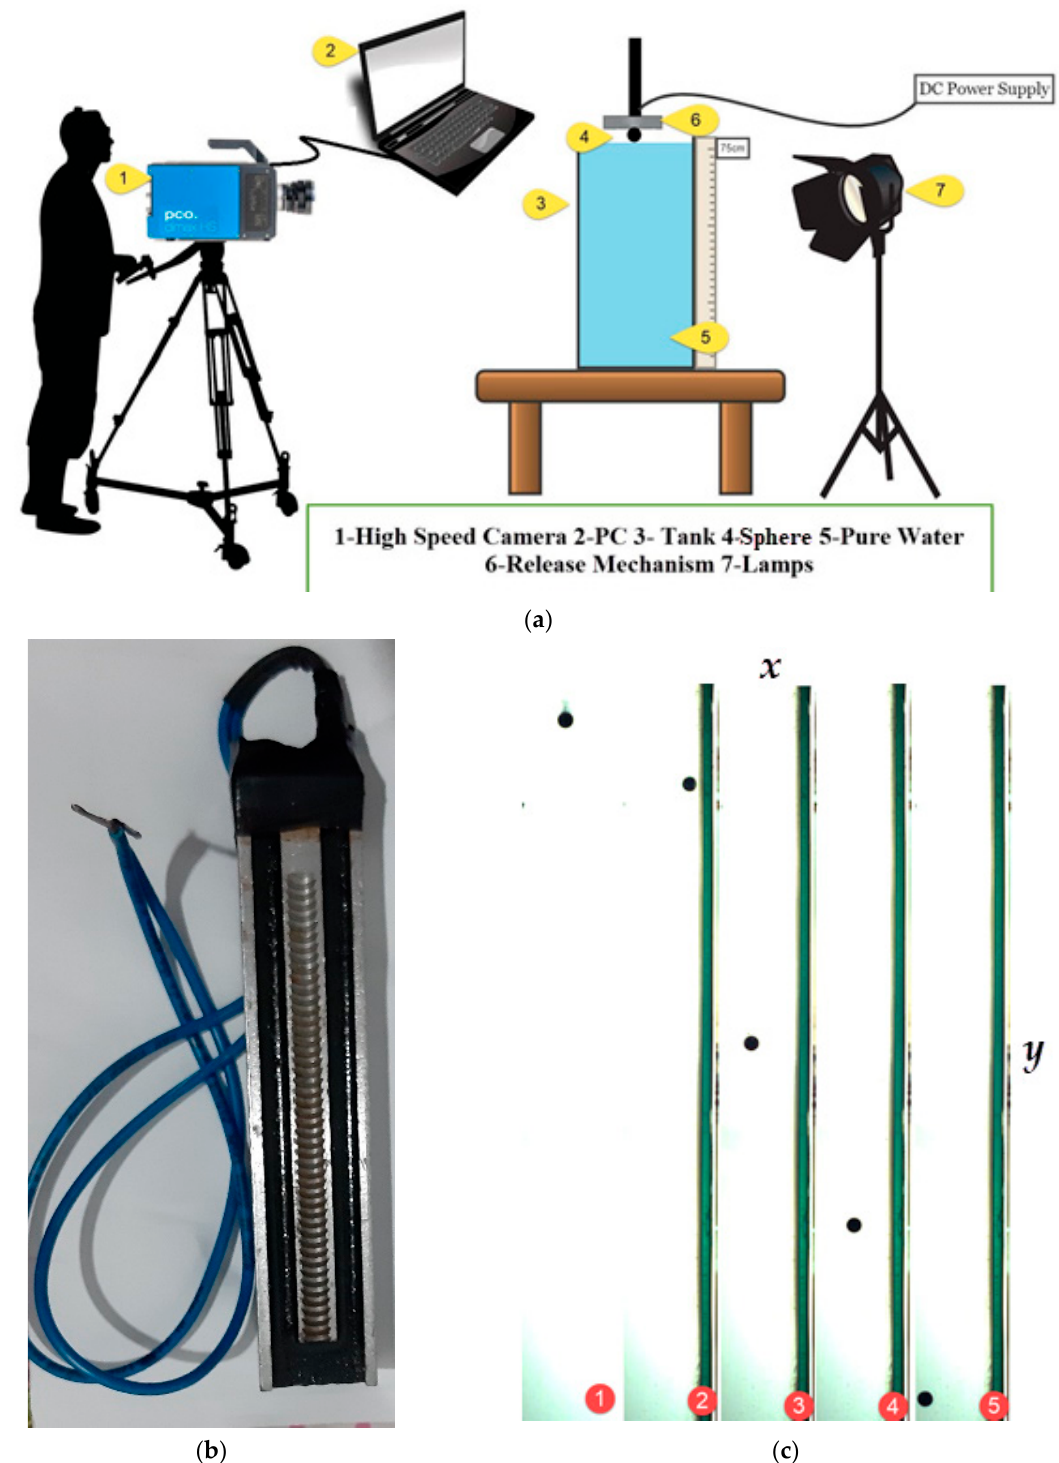
Figure 1. ( a ) The schematic laboratory setup, ( b ) magnetic holder, and ( c ) one of the captured images at different non-dimensional times: (1) the sphere at 300 °C away from the wall for t* = 0.08, (2) the sphere at the ambient temperature near the wall at t* = 19 (where t* is non dimensional time), (3) the sphere at 100 °C near the wall at t* = 47, (4) the sphere at 200 °C near the wall at t* = 72, and (5) the sphere at 300 °C near the wall at t* = 0.94.